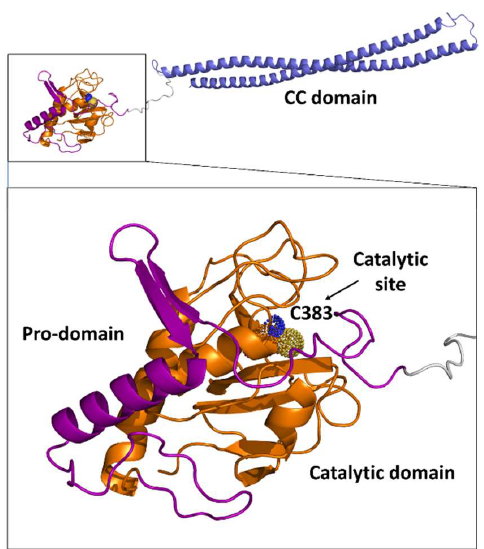
Figure 6. Cartoon representation of the entire structure of RipA: the catalytic and pro-domains (PDB code 3ne0) are shown in orange and purple, respectively. The catalytic C383 is highlighted in dot representation. The helical domain (PDB code 6ewy) is shown in blue; the linker is shown in grey.